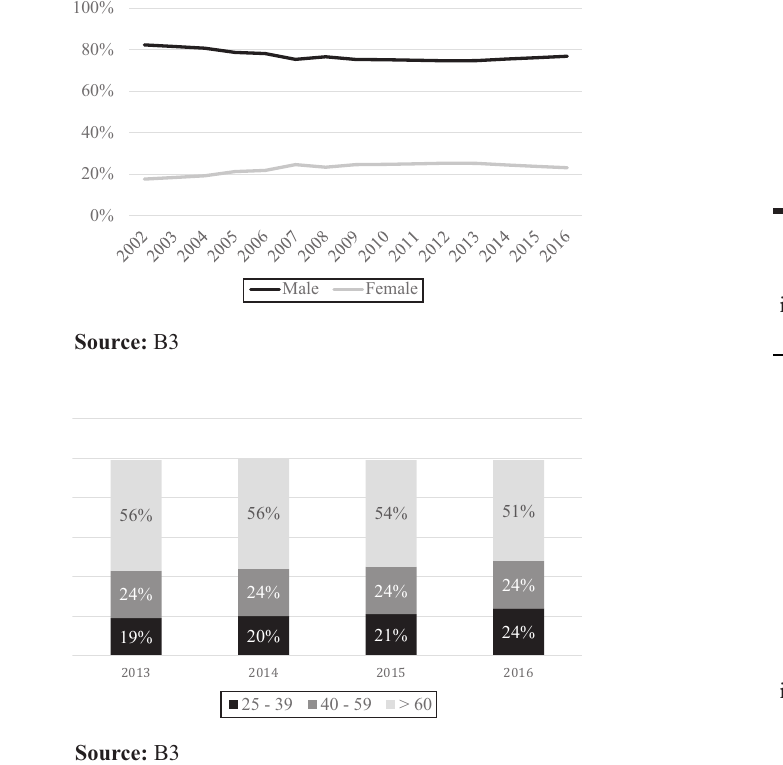
Figure 4. Individual investors